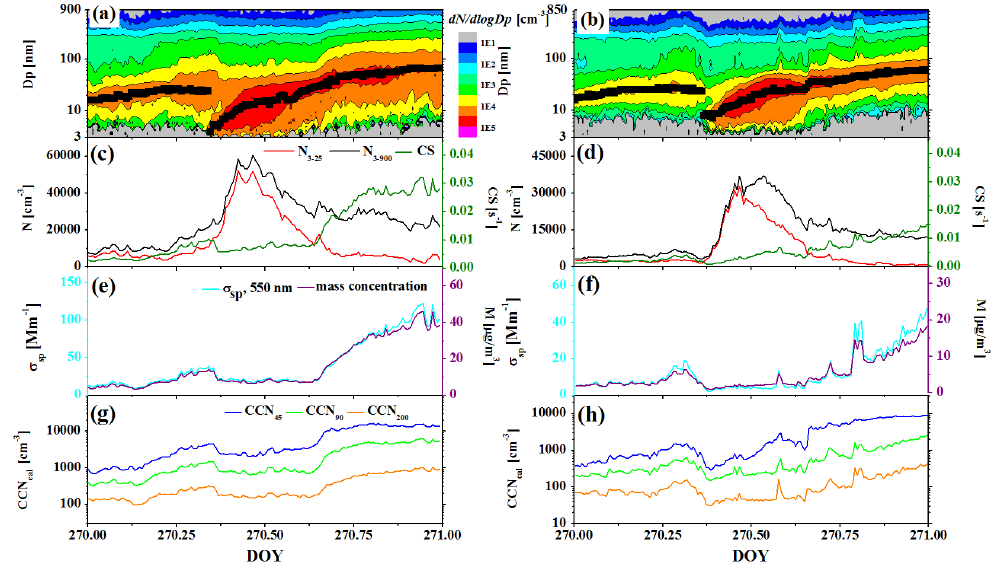
Fig. 4. (a, b) The particle number size distributions and mean diameters of the dominating mode (black square); (c, d) the evolution of condensation sink (CS, olive) and the number concentrations of nucleation mode ( N 3 − 25 , red) and total ( N 3 − 900 , black) particles; (e, f) the simulated particle light scattering coefficient at 550nm ( σ sp , cyan) and mass concentration (M, purple); and (g, h) the calculated CCN number concentration (CCN cal ) in certain diameter